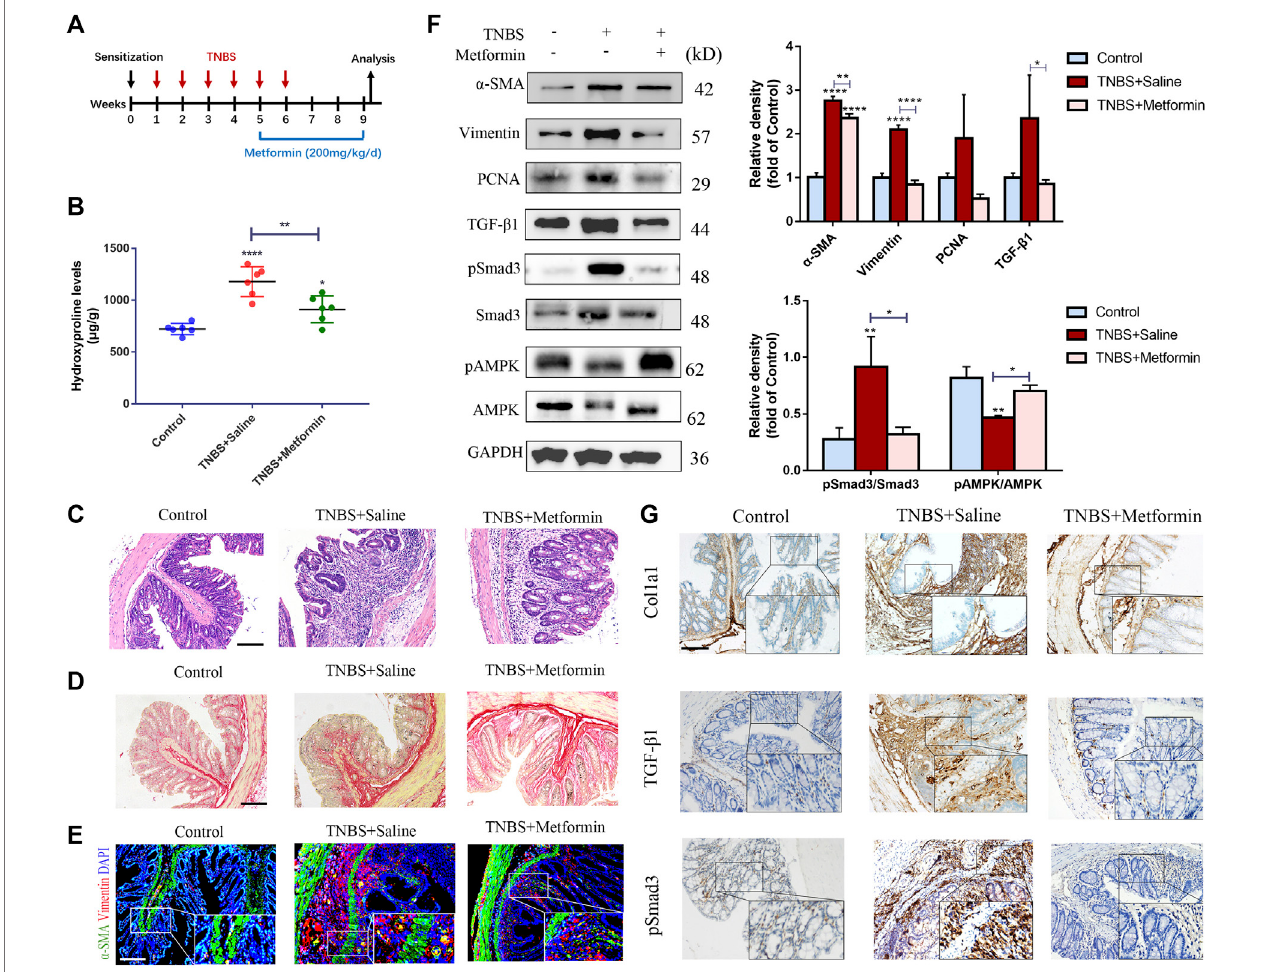
FIGURE 3 | Therapeutic metformin application attenuates intestinal fi brosis in TNBS mice model. (A) Mice experimental protocol of TNBS colitis. (B – D) Colonic tissueswereanalyzedwith (B) Hydroxyprolineassay, (C) H&Estainingand (D) SiriusRedstainingatweeknine( n =6/group). (E) IFstainingfor α -SMAandVimentinwere conductedincolonslices( n =6/group). (F) Expressionof fi broticandproliferativemarkerswasanalyzedviawesternblotofcolontissues.Relativedensityofeachprotein toGAPDHandpSmad3/Smad3 ratios areshown. (G) Colontissue specimensofmicewerestainedbyIHCforCol1a1,TGF- β 1andpSmad3.Scalebars,100 μ m. Quantitative results were analyzed by one-way ANOVA test. * p < 0.05; ** p < 0.005; **** p < 0.0001.